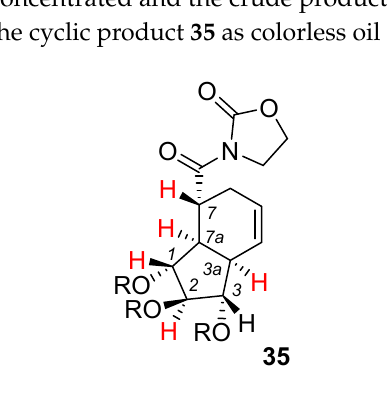
Figure 13. The structure of triene 34 and the numbering of the atoms.